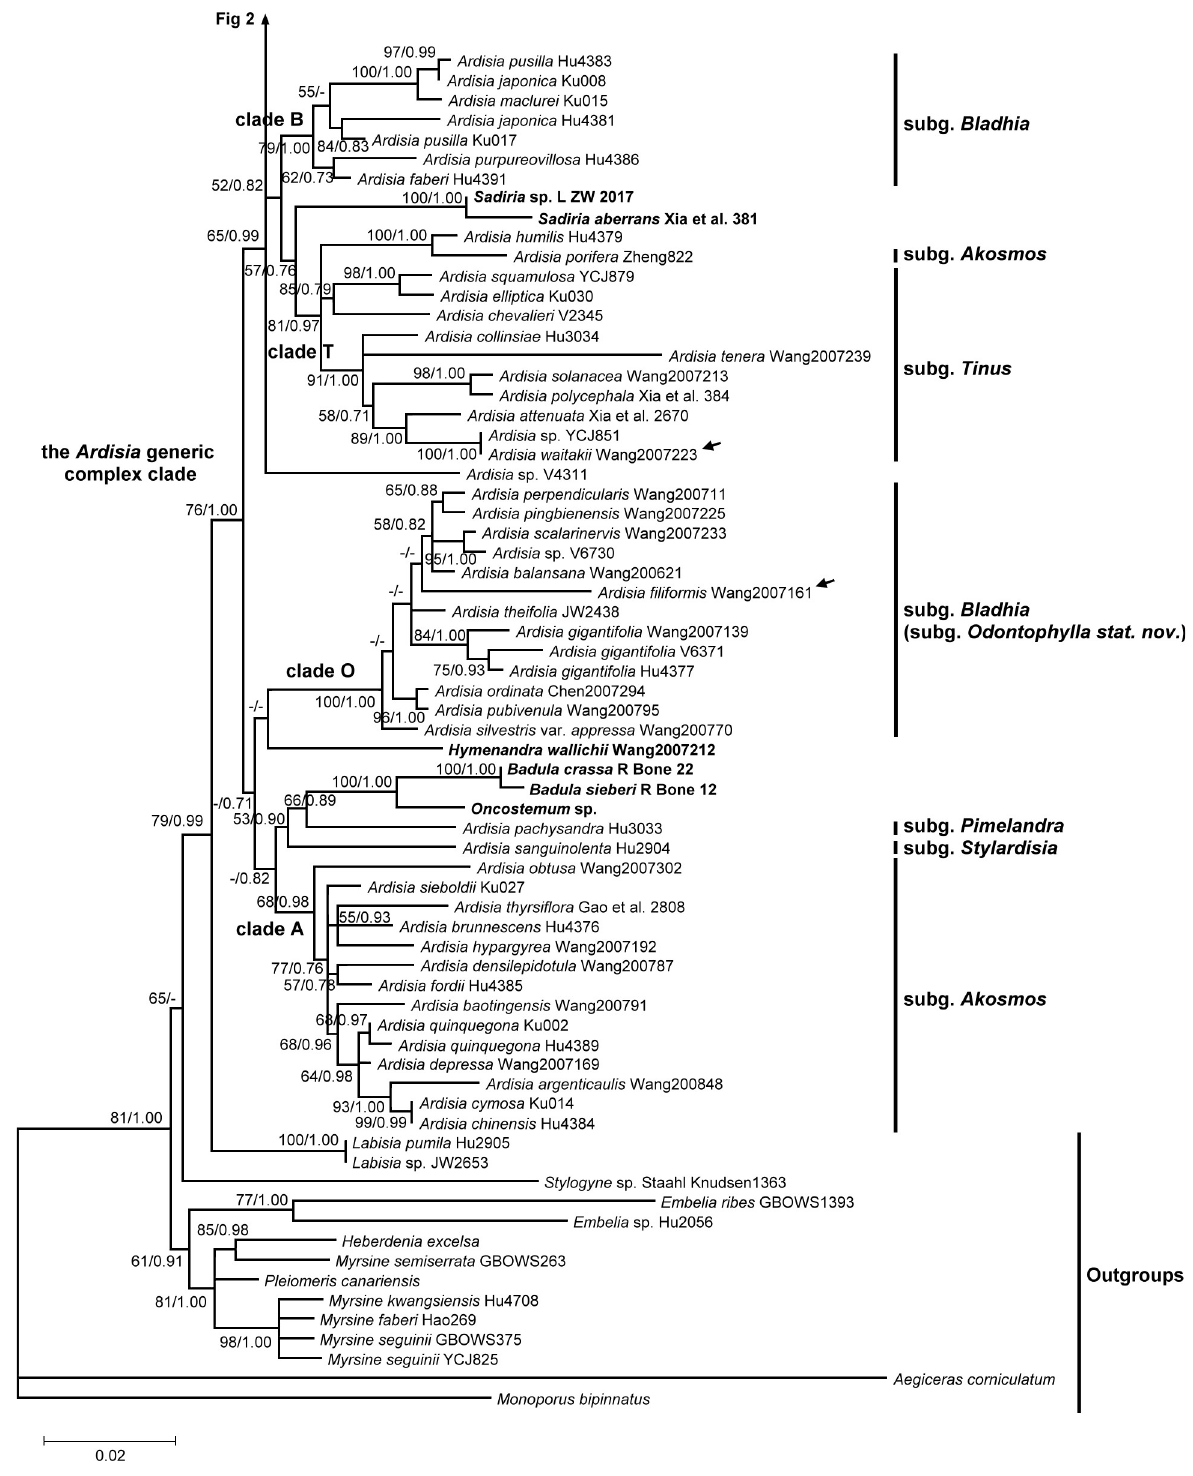
Fig 1. Phylogeny of Ardisia and allies inferred using maximum likelihood (ML) based on nuclear ITS sequences. Lower half of the tree. Numbers at branches are ML bootstrap support (ML BP) values and Bayesian posterior probabilities (BI). ML bootstrap support values are indicated only if at least 50, and the Bayesian posterior probabilities are indicated only if at least 0.7. Alternative branching between the two different analyses is showed as no support at the branch. Non- Ardisia species nested within the Ardisia generic complex are shown in boldface. Arrows indicate the presumed misidentification. Collection numbers (or other voucher information) are labeled after species names.